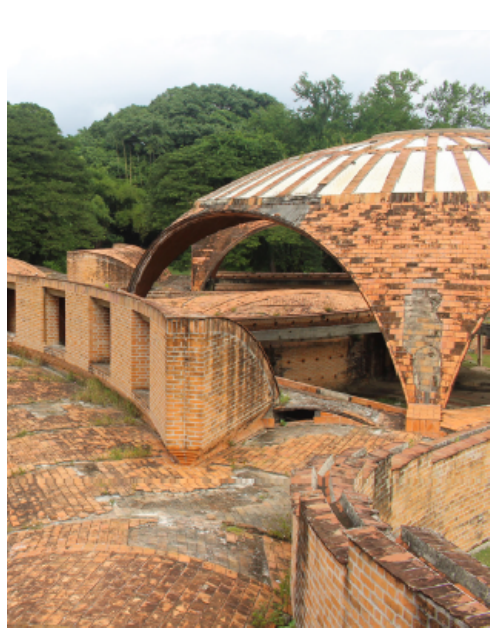
Figure 4. National Ballet School, Havana, Cuba: